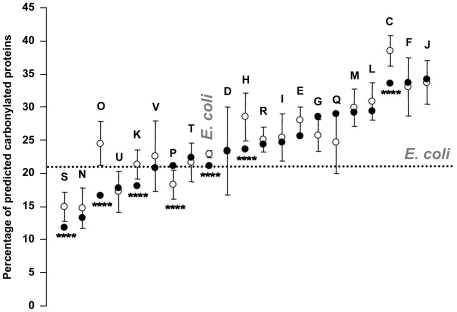
Percentage of predicted CP within functional COG classes.The predictive CSPD model was run on all protein classes, leading to the determination of the percentage of predicted CP for the standard proteome (Black circles) for each protein class. The average (open circle) and the standard deviations obtained for the 1000 shuffled proteomes (see Materials and Methods section) are indicated for each class. The asterisks highlight significant differences between shuffled and standard proteome in terms of percentages of predicted CP (p value <0.005). Designations of functional categories: C, energy production and conversion, D, cell cycle control and mitosis, E, amino acid metabolism and transport, F, nucleotide metabolism and transport, G, carbohydrate metabolism and transport, H, coenzyme metabolism, I, lipid metabolism, J, translation, K, transcription, L, replication and repair, M, cell wall/membrane/envelope biogenesis, N, cell motility, O, post-translational modification, protein turnover, chaperone functions, P, inorganic ion transport and metabolism, Q, secondary metabolite biosynthesis, transport and catabolism, R, general functional prediction only (typically, prediction of biochemical activity) S, unknown function, T, signal transduction, and U, intracellular trafficking and secretion, V, defense mechanisms. The dotted line represents the percentage of predicted CP for the whole standard E. coli proteome.